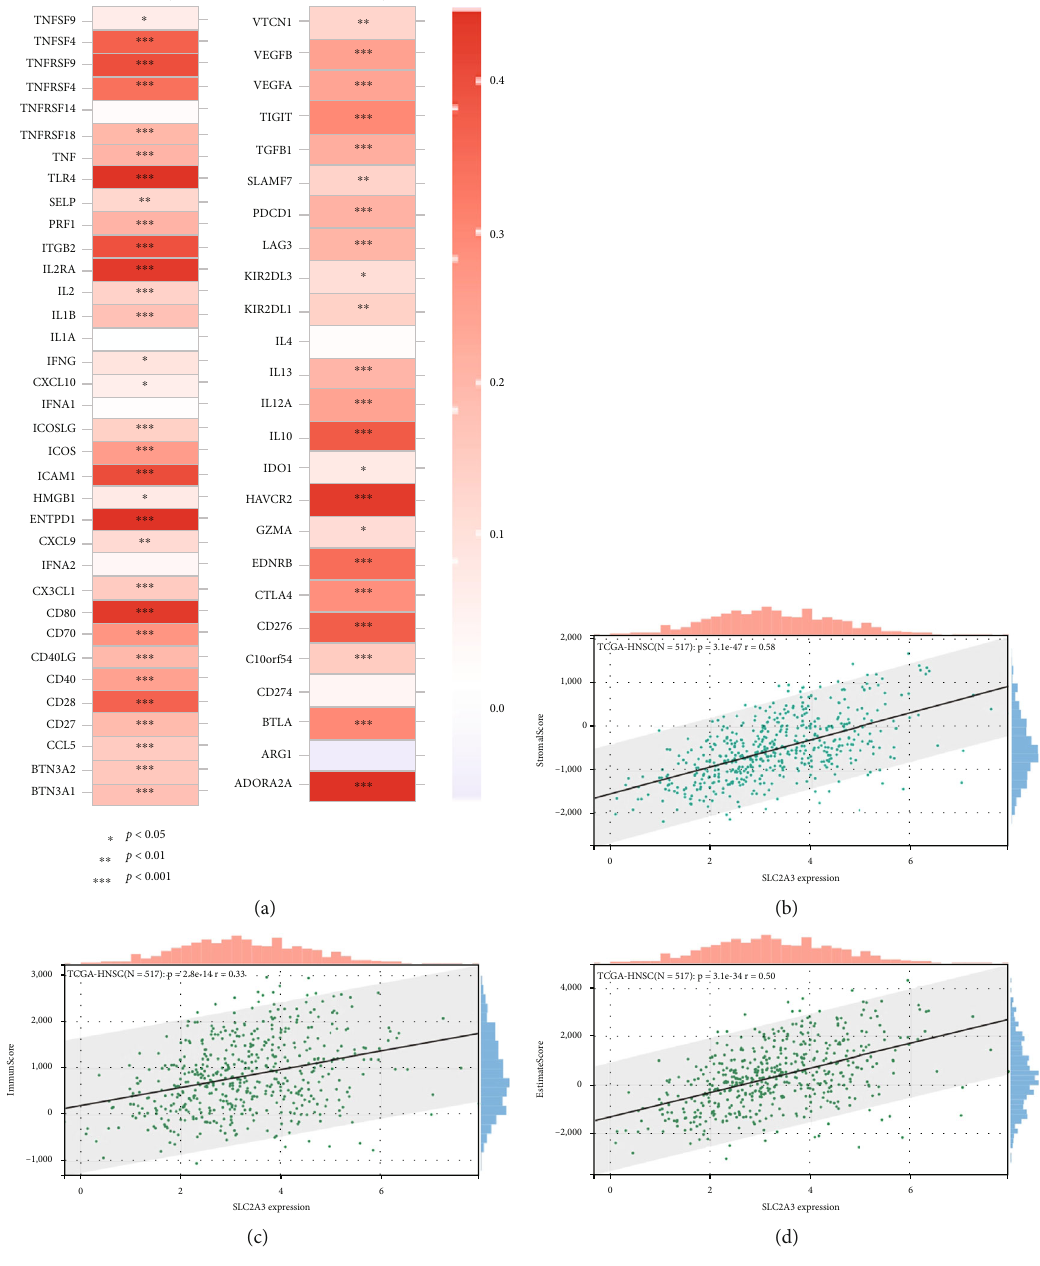
Figure 8: Relationship of SLC2A3 expression with ICP genes and ESTIMATE score in HNSCC. Of 60 ICP genes, 53 signi fi cantly correlated with SLC2A3 expression in HNSCC (a). Signi fi cantly positive relationships were noted with stromal score ( P = 3 : 1e − 47 ), immune score ( P = 2 : 8e − 14 ), and ESTIMATE score ( P = 3 : 1e − 34 )